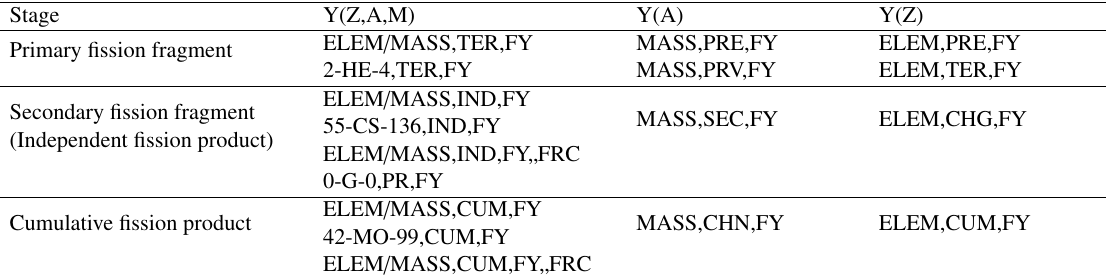
* CHG = charge, CHN = chain, CUM = cumulative, FRC = fractional, FY = fission yield, TER = ternary, IND = independent, PR = prompt, PRE = primary, PRV = provisional, SEC =